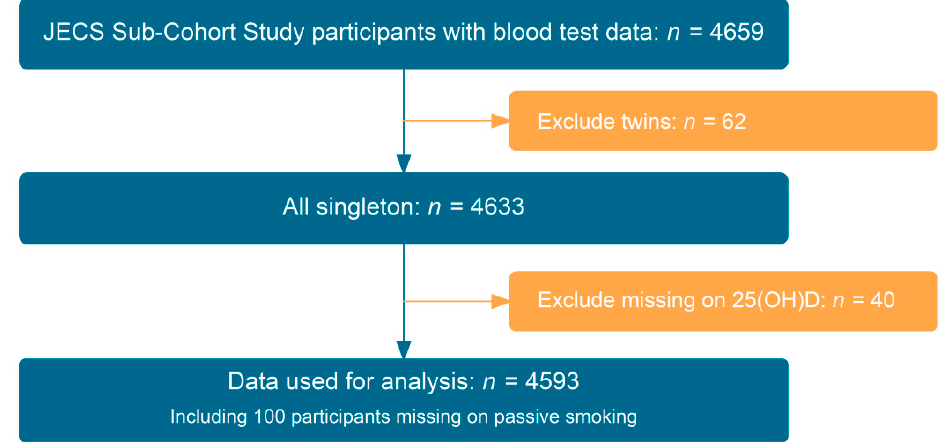
Figure 1. Study flow-chart. JECS, Japan Environment and Children’s Study.